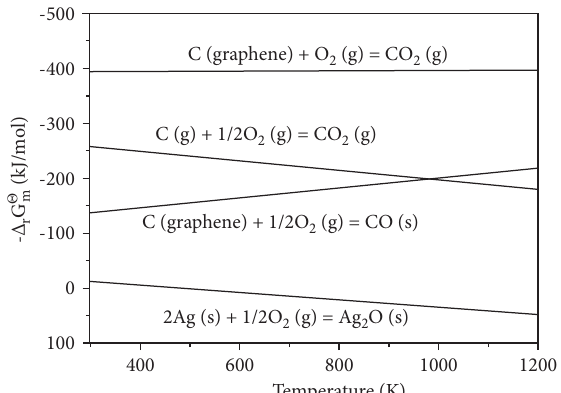
Figure 4: Ellingham